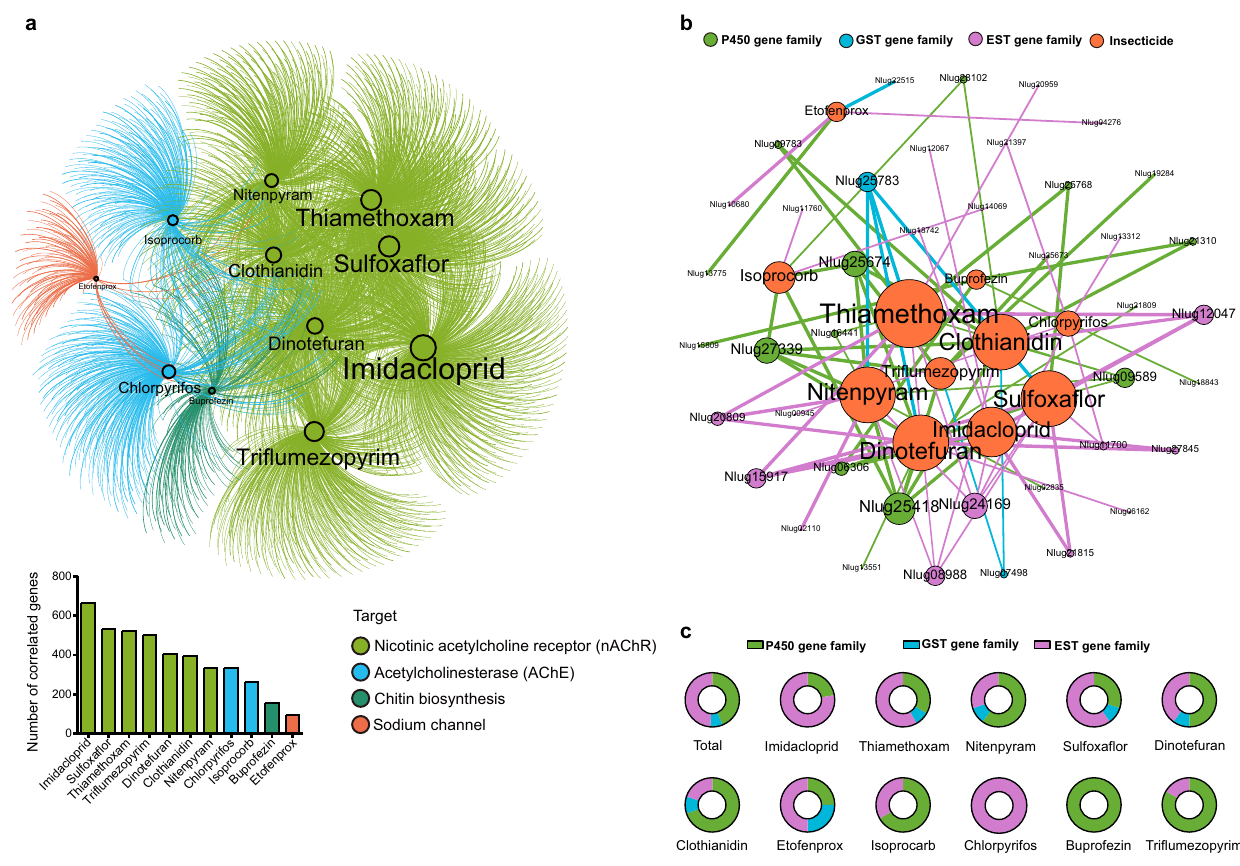
Fig. 3 Correlation networks of LC 50 values and genes expression levels. a Interaction network of LC 50 values and whole transcriptome genes expression levels, the circles are re fl ected insecticide susceptibility, and their size re fl ected the number of lines connected to them (more lines result in bigger node sizes), edges indicated the correlation between its connected nodes and nodes represented genes expression levels, while the color indicated a different target of insecticides. Barplot in the lower right corner described the number of genes correlated with each insecticide. b Interaction network of LC 50 value and detoxifying genes expression levels. The color of nodes and edges represented the type of detoxifying genes. c Proportion of different detoxifying genes associated with each insecticide which showed in the network. In both networks, the size of the node with labels indicates the number of genes associated with it. The line between the two circles indicates a signi fi cant correlation ( P < 0.05). The color of the circle represented the type of detoxifying genes. Detailed information is shown in Supplementary Data